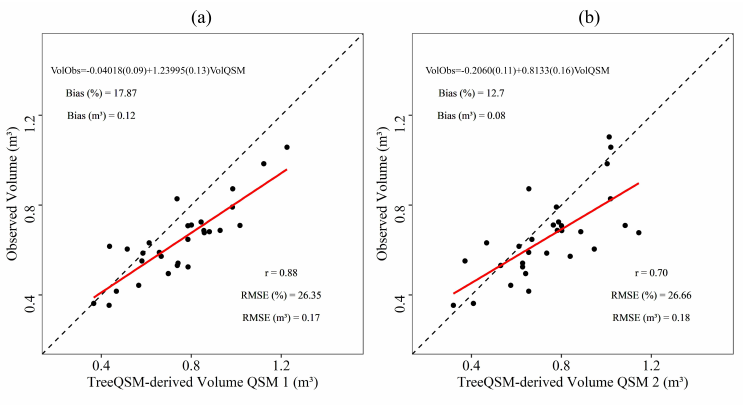
Figure 5. Relationship between individual field-based and QSM-derived tree volume from QSM1 ( a ) and QSM2 ( b ).